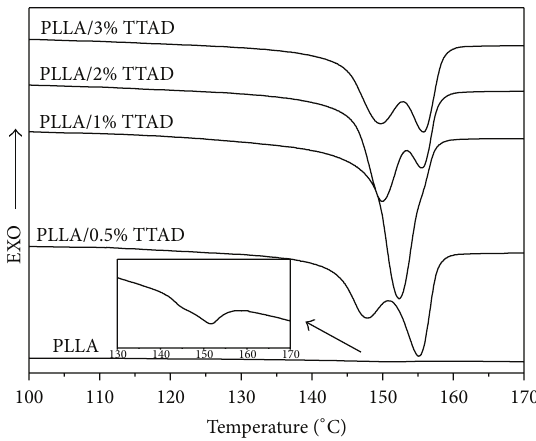
Figure 9: Melting behavior of neat PLLA and PLLA/TTAD at a heating rate of 10 ∘ C/min after nonisothermal crystallization at a cooling rate of 1 ∘ C/min.